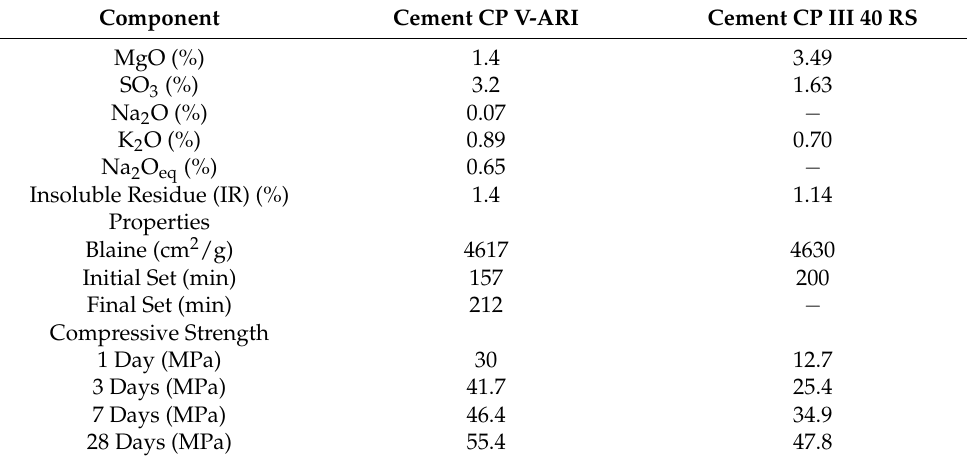
Table 1. Chemical composition, physical properties, and mechanical performance of the types of cements